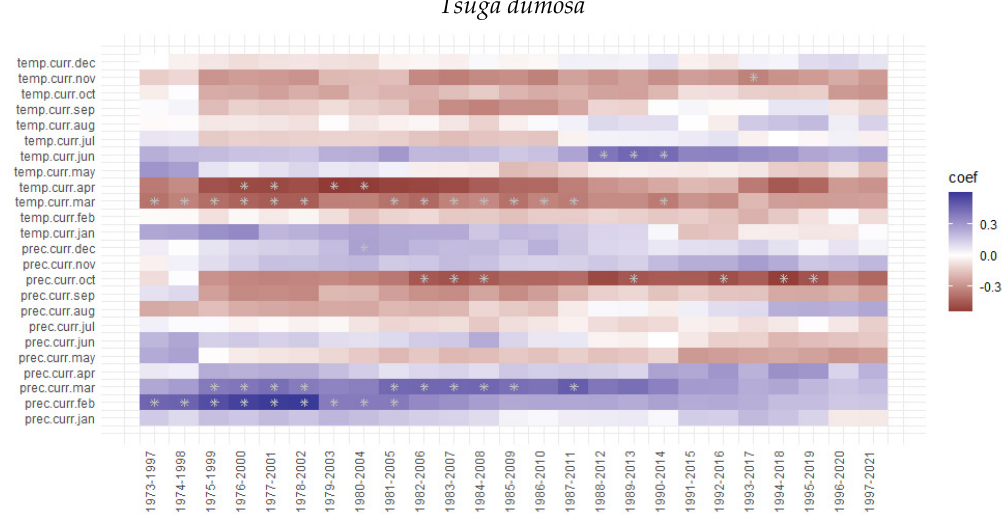
Figure 5. Moving correlations (25-year window) between tree ring growth of Abies pindrow , Pinus wallichiana , and Tsuga dumosa and climatic variables (mean temperature and precipitation) for the period of 1973 to 2021. The color coding signifies the correlation coefficient, and significant correlations are symbolized by white asterisks.